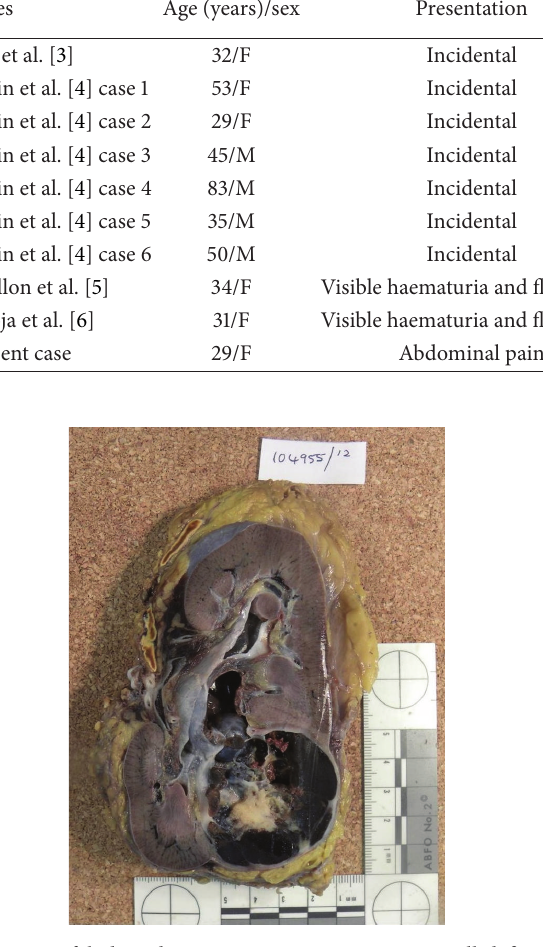
Figure 3: Left kidney demonstrating a 6.5 cm ×4.5 cm well-defined, multiloculated cystic mass within the lower renal pole. The cut surface of the tumour is brown with a central, solid white